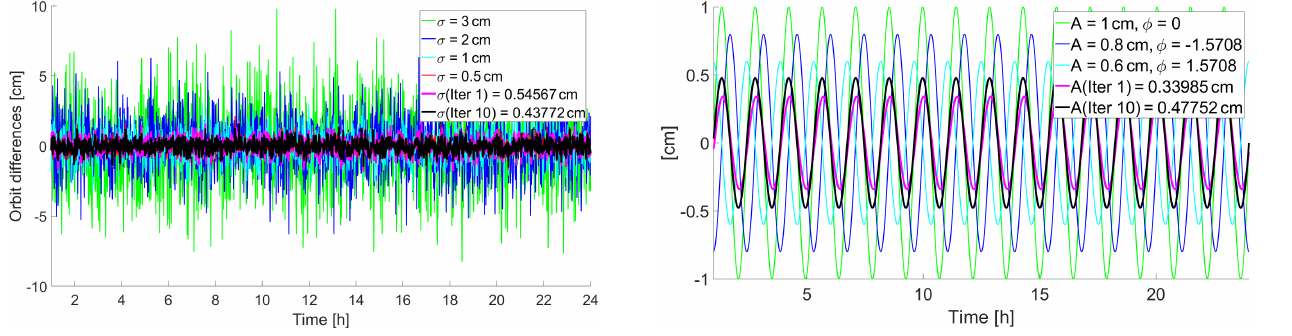
Figure 4. Combination of solutions affected by white noise using the weighting scheme given by VCE.